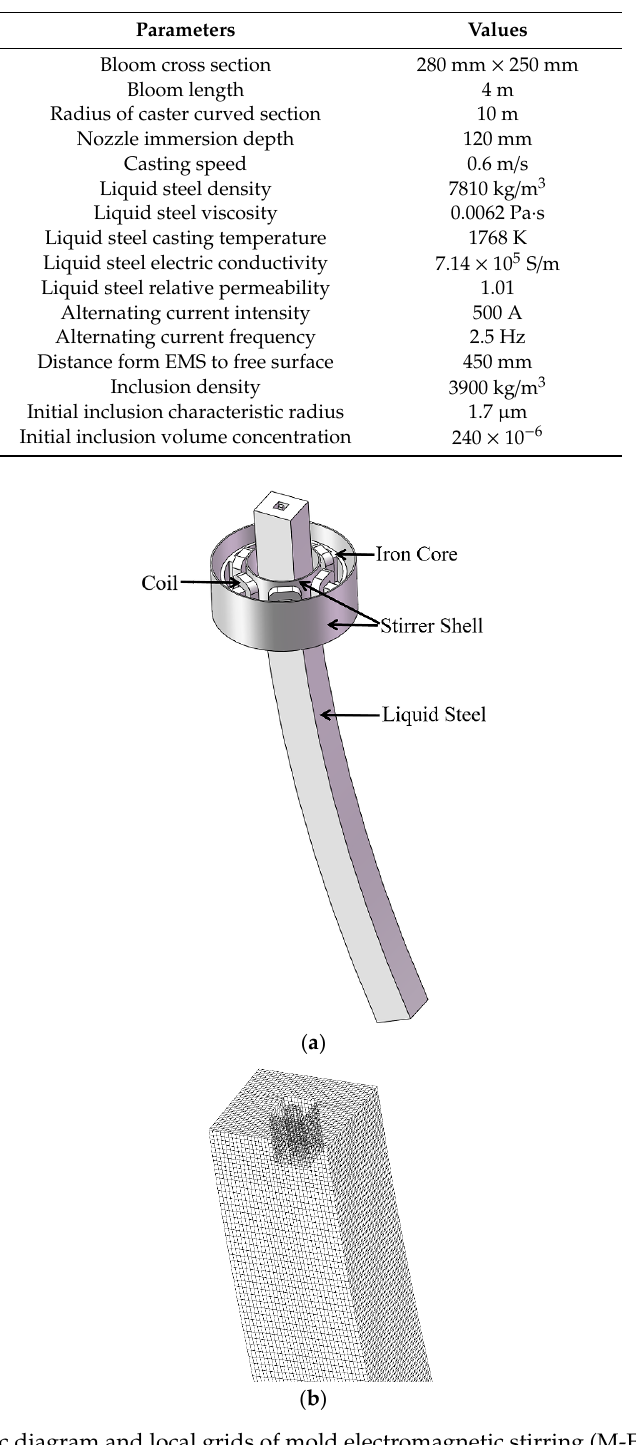
Figure 3. Schematic diagram and local grids of mold electromagnetic stirring (M-EMS) with curved continuous casting bloom: ( a ) schematic diagram; ( b ) local grids. Table 2. Geometric and physical parameters.